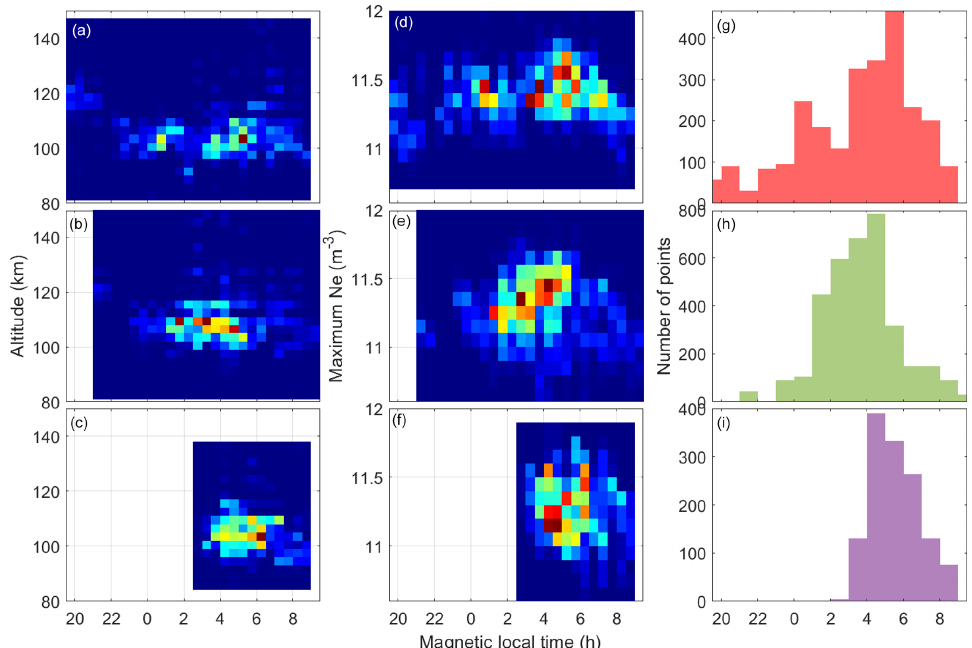
Figure 6. Two-dimensional histogram of altitude of maximum electron density (a–c) , magnitude of maximum electron density (d–f) , and distribution of the occurrence of data points (g–i) during different types of pulsating aurora: PPA, APA, and PA from top to bottom.